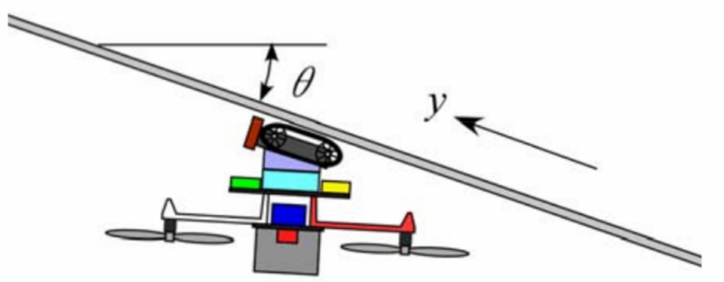
Figure 7. A recent novel innovation in hybrid locomotion UAVs. The pivoting traction crawler UAV performs IST on angled infrastructure surfaces inaccessible to engineers without gantries